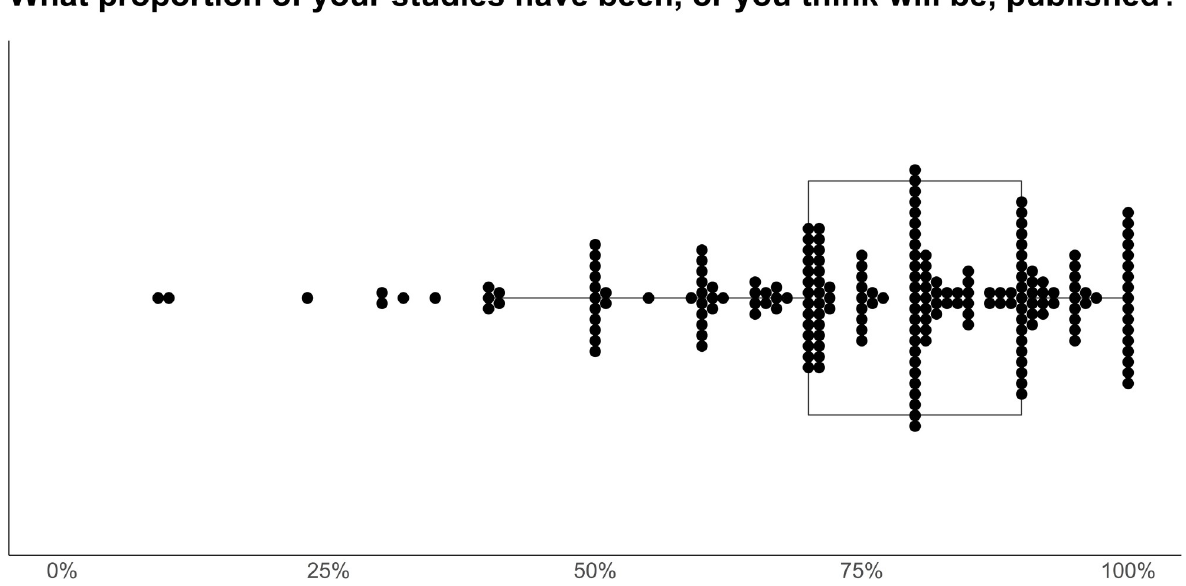
Fig 10. Animal cognition researchers’ self-reported proportion of studies that they have run and then published. N = 208. Each dot represents one researcher’s answer to the question “What percent of the studies that you have performed have been published and/or you think will be published?”, and a boxplot showing the median and inter-quartile ranges is laid underneath.